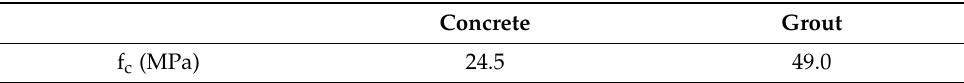
Table 2. Material characterizations of concrete and grout used in the FE analysis [21].